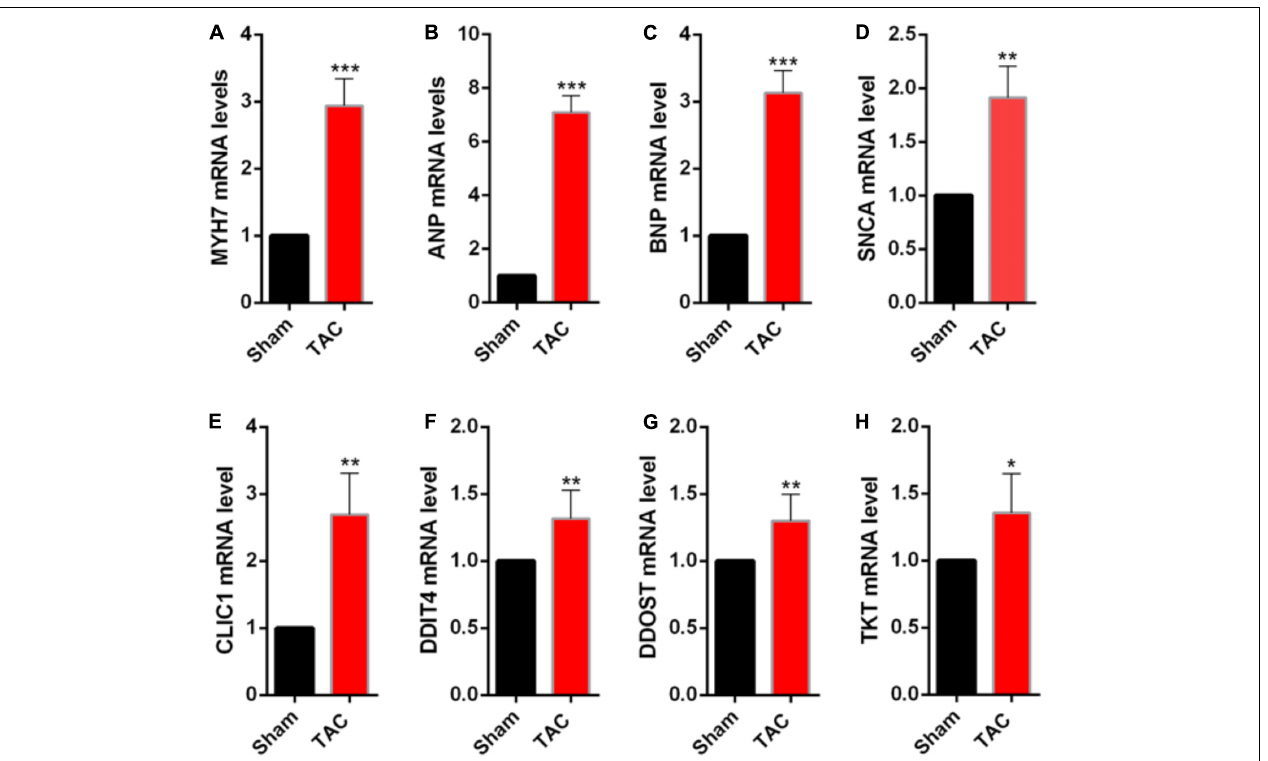
FIGURE 4 | Validation of the differentially expressed NMGenes in TAC mice. (A–C) mRNA of the genes indicating cardiac hypertrophy increased. (D–H) mRNA of the differentially expressed NMGenes also increased. Data are presented as the mean ± SD. * P < 0.05, ** P < 0.01, *** P < 0.001 (Student’s t -test); n = 5 samples per group. TAC, transverse aortic